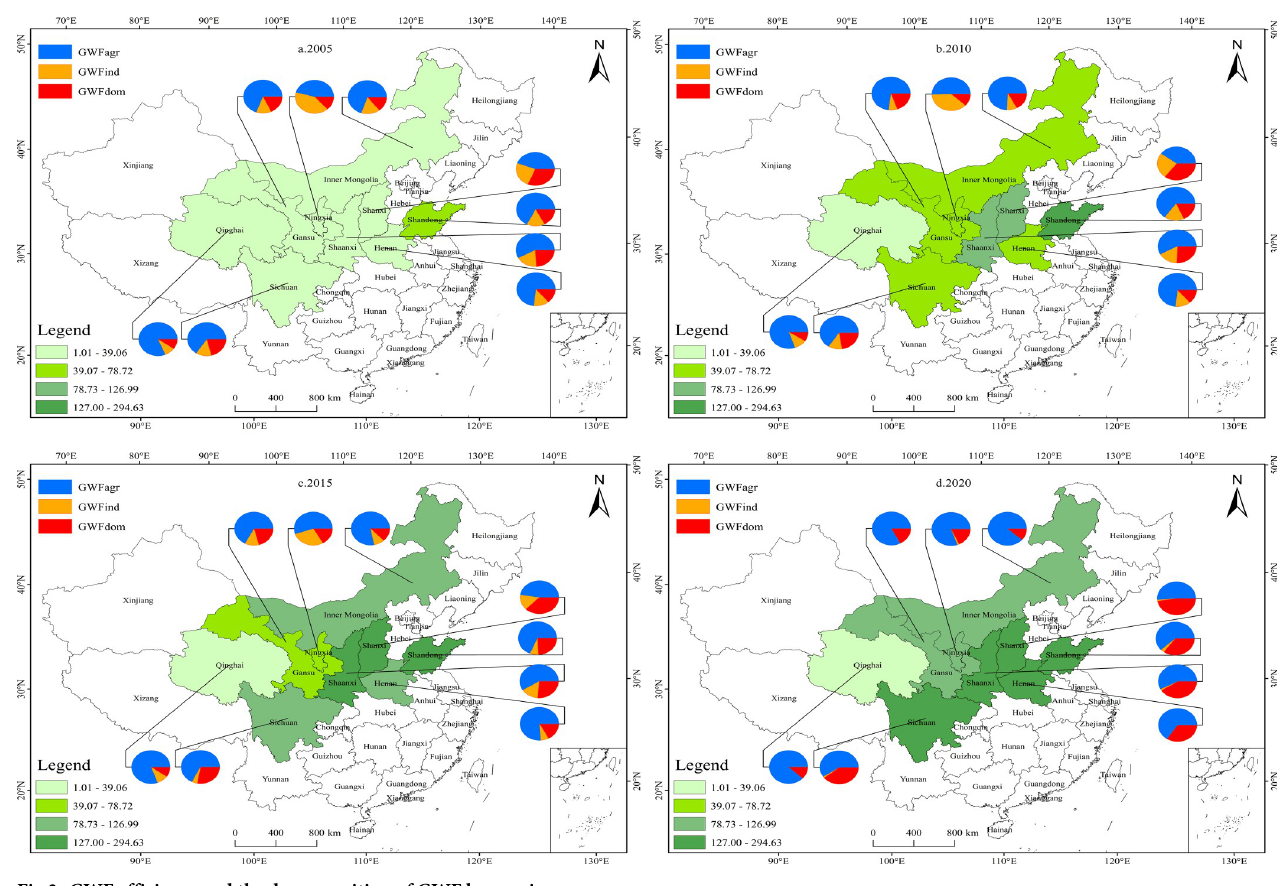
Fig 3. GWF efficiency and the decomposition of GWF by